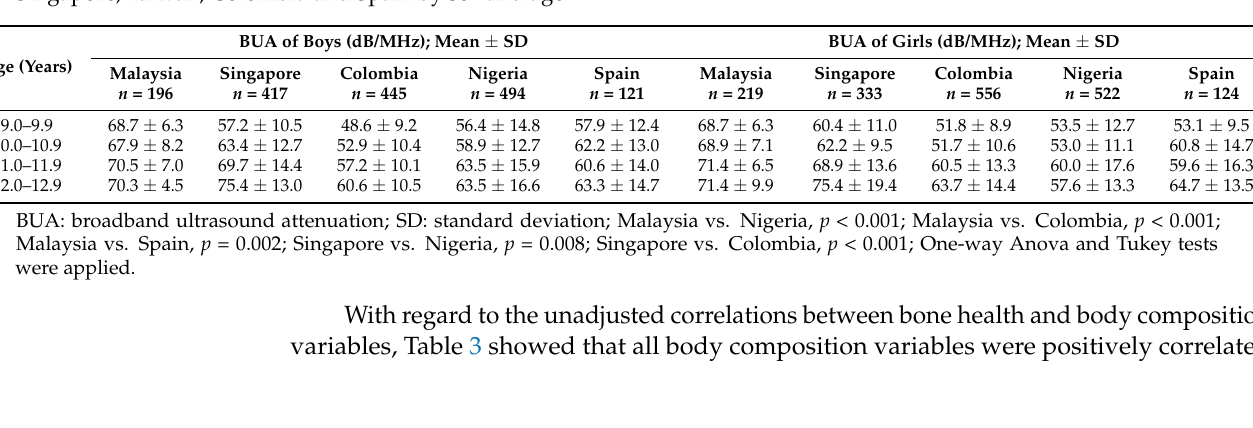
Table 2. Comparison of mean broadband ultrasound attenuation (BUA) for schoolchildren from Malaysia (present study), Singapore, Taiwan, Colombia and Spain by sex and age. BUA of Boys (dB/MHz); Mean ± SD BUA of Girls (dB/MHz); Mean ± Age (Years)